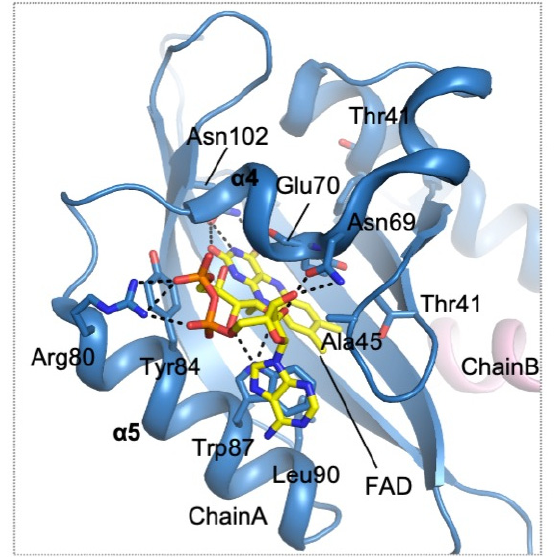
Figure 9. Residues involved in FAD sensing by A. vinelandii NifL. Ribbon diagram showing the structure of NifL (chains A and B are colored blue and pink, respectively) in complex with FAD (carbon atoms are colored yellow). The side chains interacting with NifL are shown as sticks and are colored by atom type. Dotted lines denote the hydrogen bonds established between NifL and bound FAD. Table 1. Bacterial redox sensors . Abbreviations: RD, Regulatory domain; DBD, DNA binding domain; FL, Full-length; P. gingivalis , Porphyromonas gingivalis ; P.aeruginosa , Pseudomonas aeruginosa ; E. coli , Escherichia coli ; C glutamicum , Corynebacte- rium glutamicum ; N. meningitidis , Neisseria meningitidis ; V. vulnificus , Vibrio vulnificus ; B. subtilis , Bacillus subtilis ; S. typhi- murium , Salmonella typhimurium ; L. interorgans , Leptospira interrogans ; S. pyogenes , Streptococcus pyogenes ; C. jejuni , Campylo- bacter jejuni ; M. tuberculosis , Mycobacterium tuberculosis ; A.vinelandii , Azotobacter vinelandii ; T. aquaticus , Thermus aquaticus ; T. thermophilus , Thermus thermophilus ; T. maritima , Thermotoga maritima .